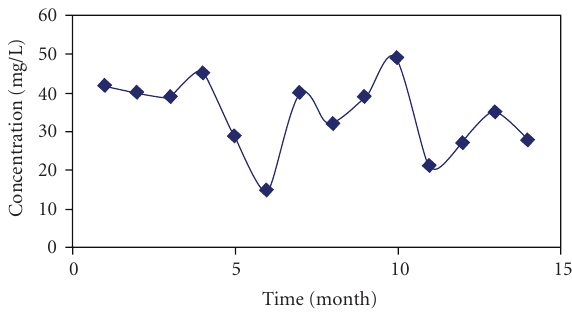
Figure 7: Total dissolved solids concentration in the